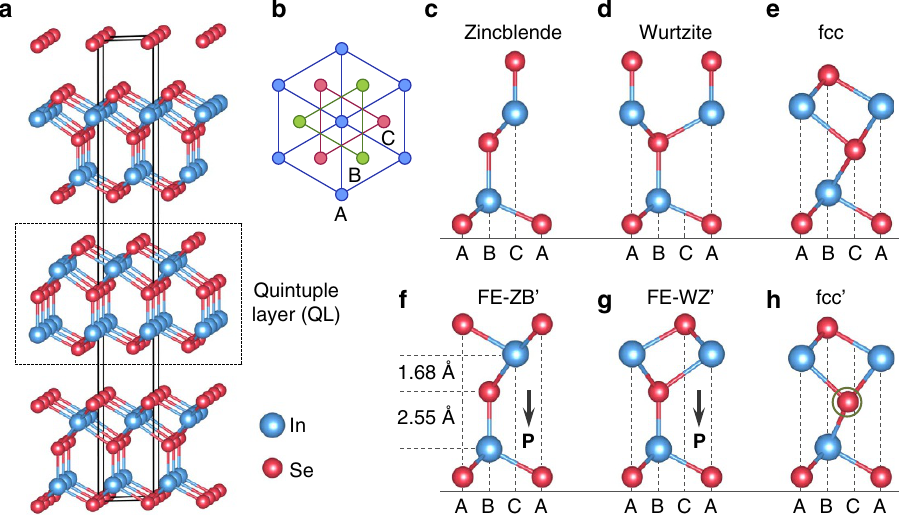
Figure 1 | Layered structures of In 2 Se 3 . ( a ) Three-dimensional crystal structure of layered In 2 Se 3 , with the In atoms in blue and Se atoms in red, and a quintuple layer (QL) is indicated by the black dashed square. ( b ) Top view of the system along the vertical direction. Each atomic layer in a QL contains only one elemental species, with the atoms arranged in one of the triangular lattices A, B or C as illustrated. ( c – h ) Side views of several representative structures of one QL In 2 Se 3 , among which the c – e structures are derived from the zincblende, wurtzite and fcc crystals, respectively. In f , the interlayer spacings between the central Se layer and the two neighbouring In layers are displayed. The black arrows in f , g indicate the directions of the spontaneous electric polarization (P) in the FE-ZB 0 and FE-WZ 0 structures,